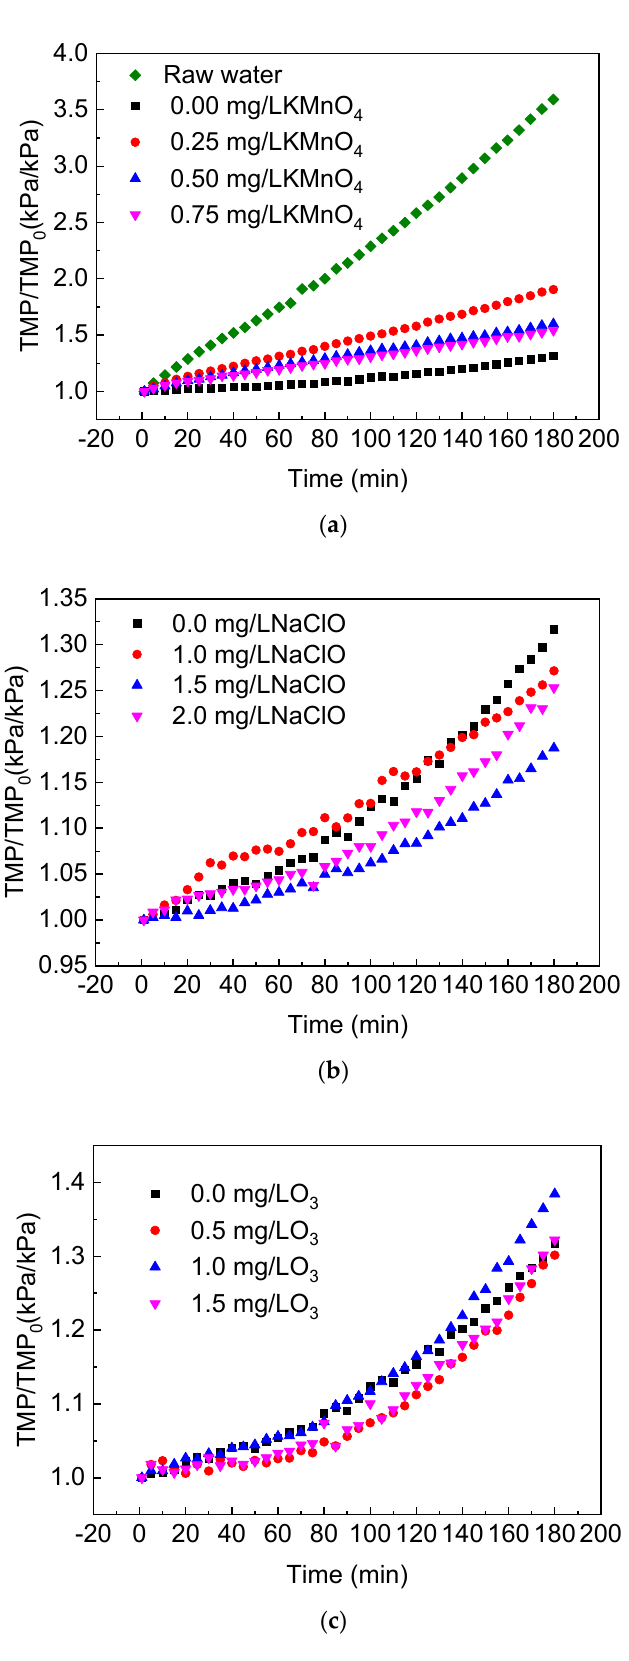
Figure 3. Effect of pre-oxidation on the specific transmembrane pressure of the coagulation/ceramic membrane process: ( a ) KMnO 4 ; ( b ) NaClO; ( c ) O 3 (the coagulant used was 2 mg/L PAC). Compared to an online coagulation/ceramic membrane filtration, adding KMnO 4 could increase the degree of membrane fouling. At 0.25, 0.50 and 0.75 mg/L KMnO 4 con- centrations, the specific transmembrane pressure rate at the end of the 180-min filtration